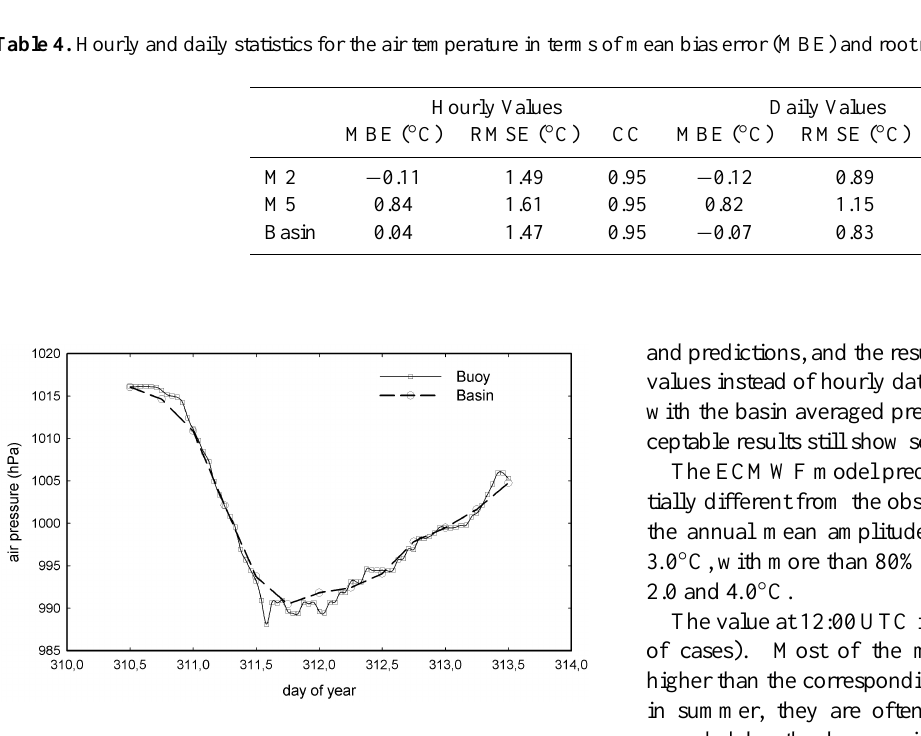
Fig. 5. Overplot of the barometric pressure drop that occurred from 5 to 9 November 2000 as measured by the buoy and predicted by the ECMWF